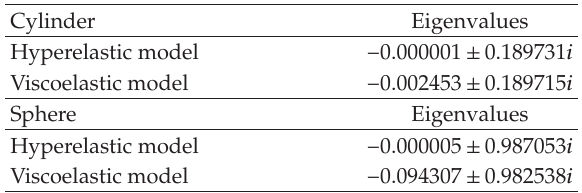
Table 3: Eigenvalues for spherical and cylindrical membrane